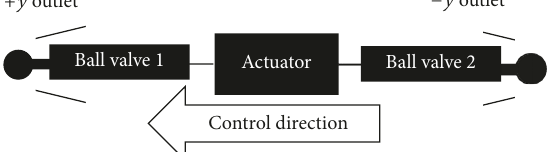
Table 2: Thrust distribution algorithm for the original